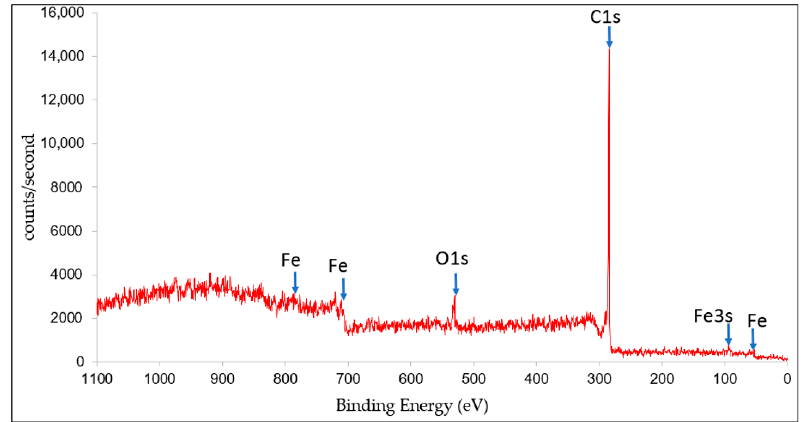
Figure 3. X-ray photoelectron spectroscopy of the BP.